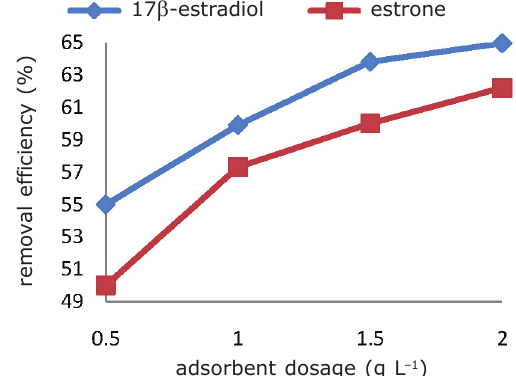
Fig. 5 – Effect of adsorbent dosage on the removal efficiency of E2 and E1 (30 min of contact time, pH 4, and 10 ng L –1 concentration of E2 and